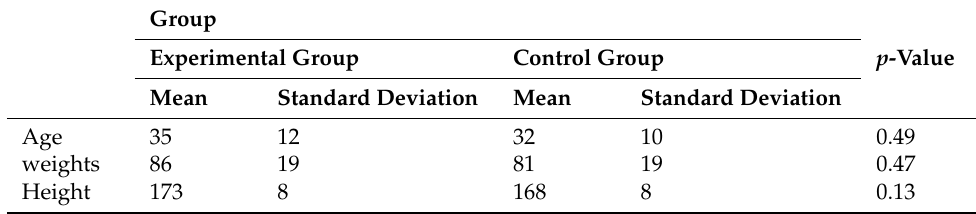
Table 2. Descriptive analysis of demographic factors.